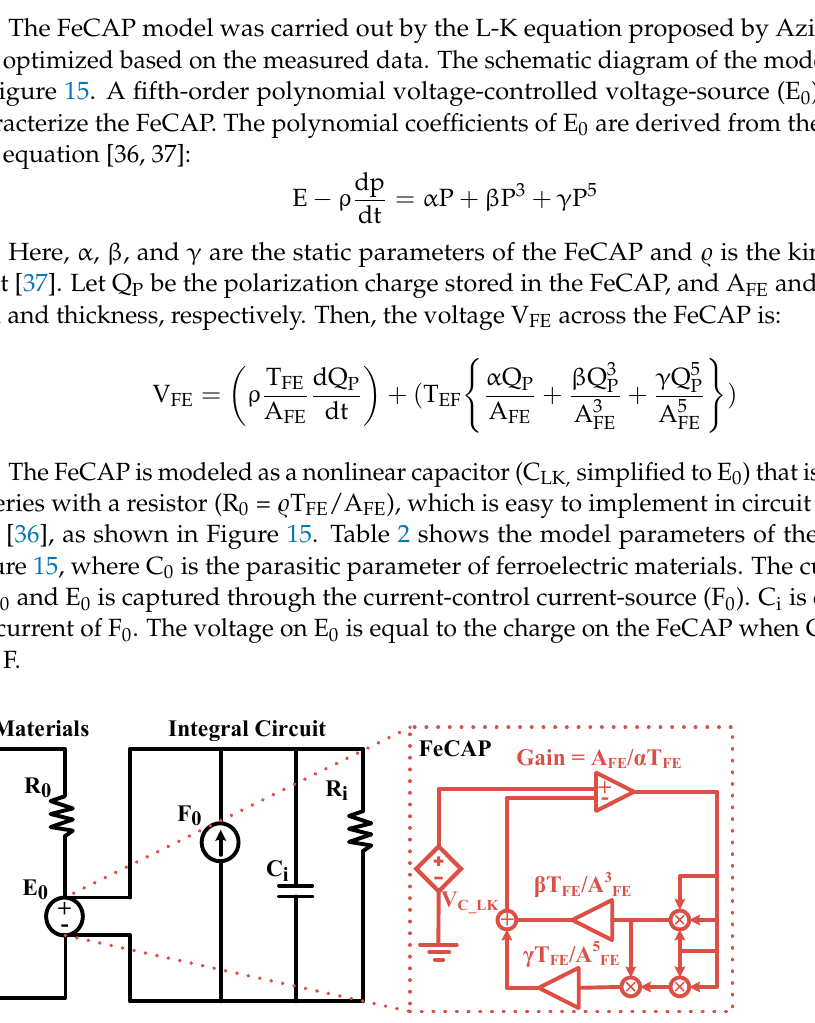
Figure 14. The endurance of the FeCAP used in this work.